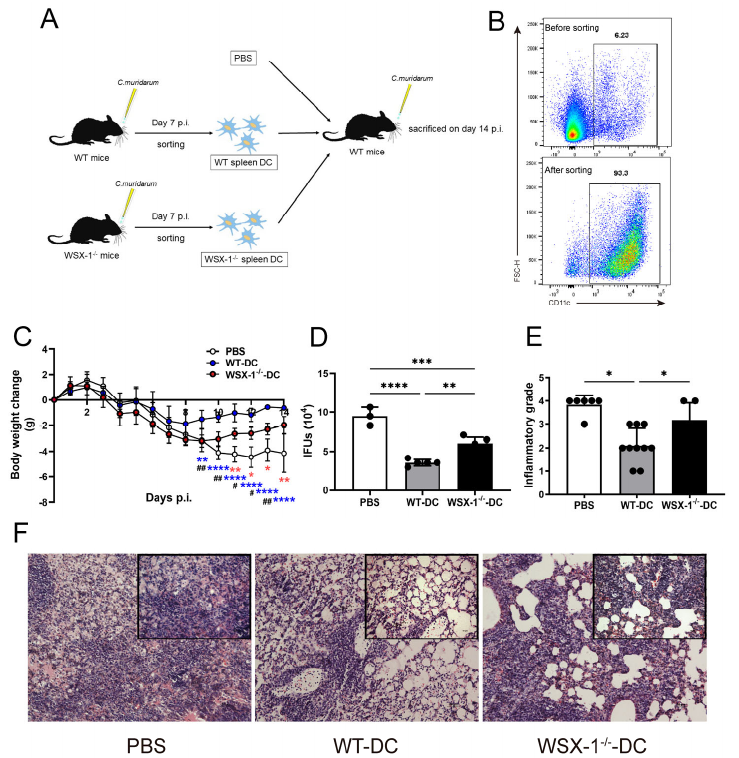
Figure 2. Disease progression of recipient mice after receiving DCs in C. muridarum lung infection. ( A , B ) WT mice and WSX-1-deficient (WSX-1 − / − ) mice were intranasally infected and sacrificed on day 7 p.i., spleen cells were isolated, and DCs were sorted with purity higher than 90% ( B ). Either 1 × 10 6 WT-DCs or WSX-1 − / − -DCs in 200 μ L PBS were adoptively transferred to naïve C57BL/6